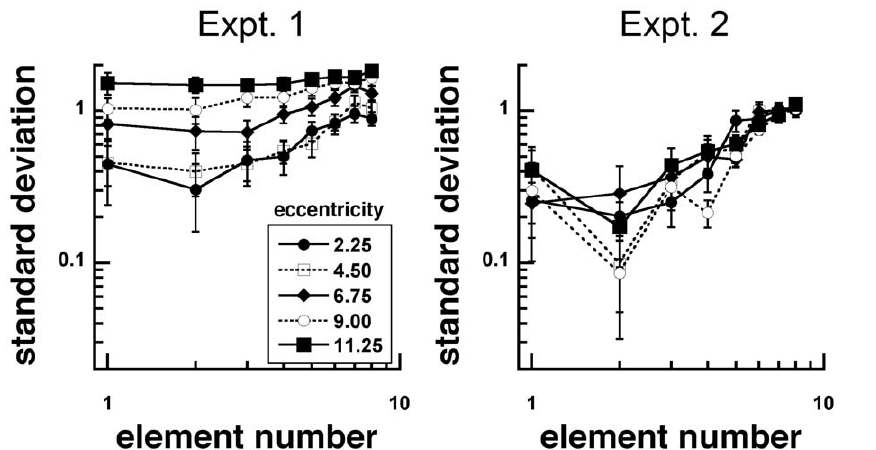
Figure 6. Mean standard deviation as a function of element number for stimuli with unscaled (Experiment 1) and scaled (Experiment 2) sizes. Response precision decreased as viewing eccentricity increased in Experiment 1, but not in Experiment 2. Response precision also decreased with increasing element number.